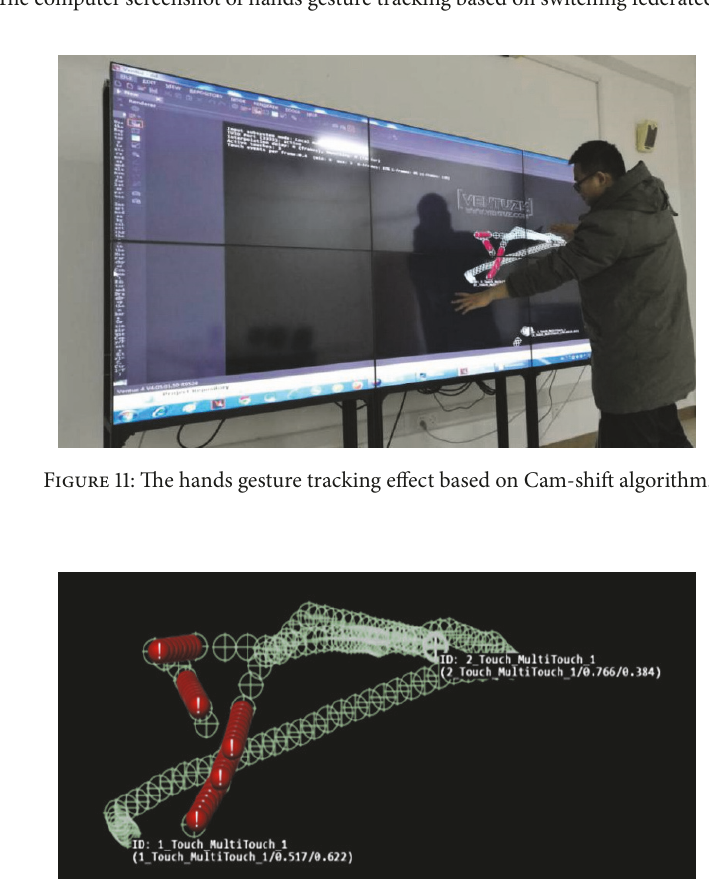
Figure 10: The computer screenshot of hands gesture tracking based on switching federated filter algorithm.